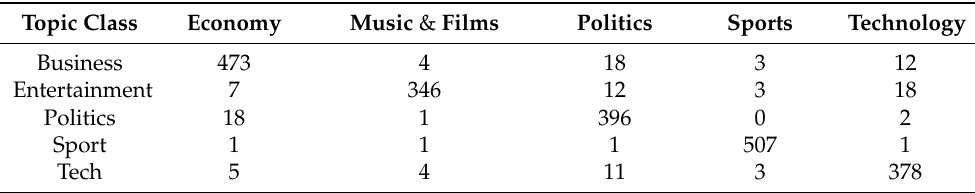
Table 4. Crosstable between preassigned classes and detected dominant topics ( γ = 0.8) for all documents of the BBC corpus.